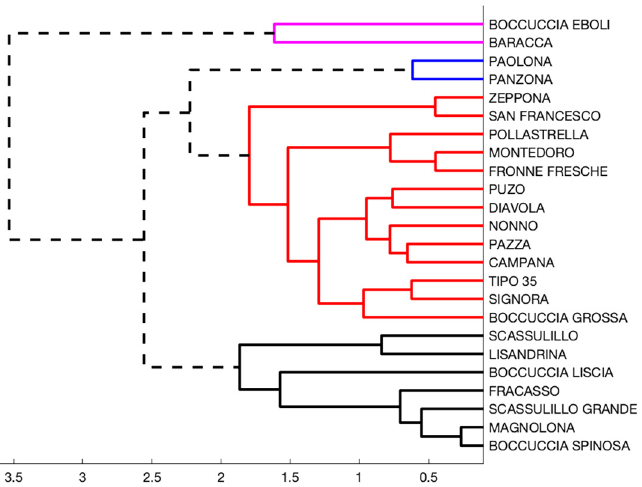
Figure 1. Hierarchical clustering of varieties obtained using a Euclidean unweighted distance and considering the normalized content of β -carotene, total polyphenols normalized content, and ascorbic acid normalized content. We used 1.9 as the cutoff distance.